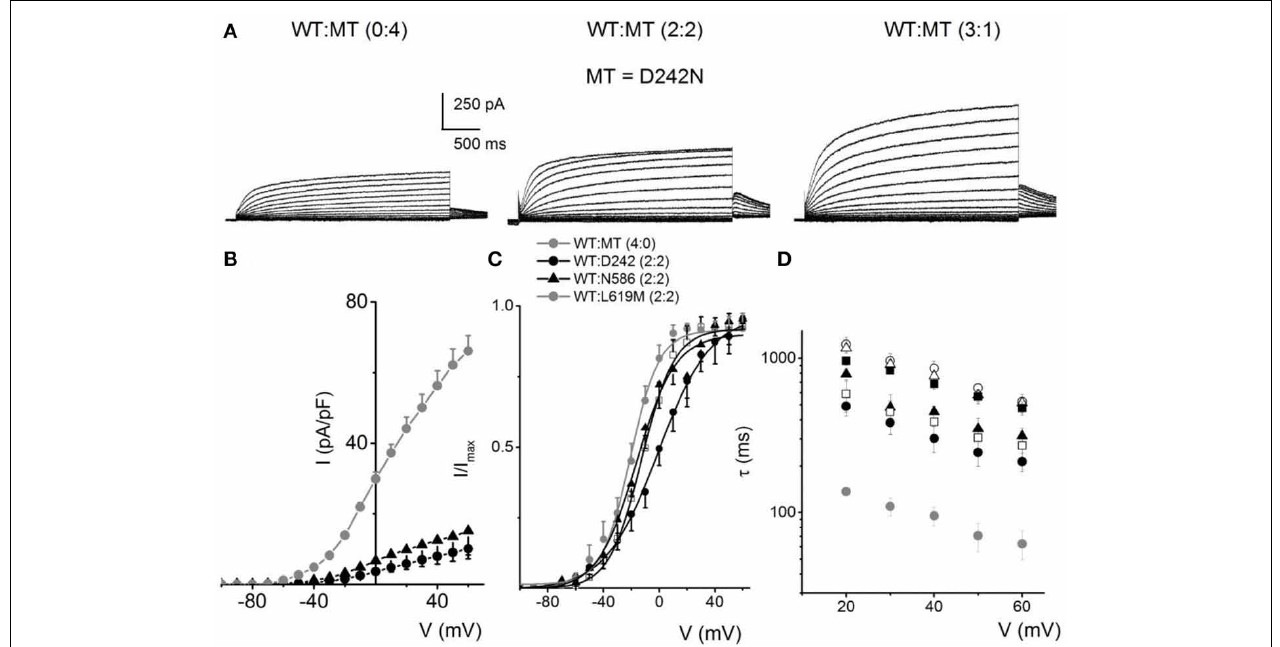
FIGURE 6 | Activation properties of homomeric and heteromeric hKv7.1 channel and RWS mutants, D242N, N586D and L619M currents. (A) Whole-cell outward currents were recorded upon expressing hKv7.1 RWS mutant (MT-D242N) channel singly (left panel). Current traces recorded after co-expressing WT hKv7.1 and MT D242N at a ratio of 1:1 (middle panel). Representative current traces for a family of K + currents obtained from a holding potential of − 80mV and stepped from − 100 to 60mV using (cid:3) V = 10mV are shown. The tail currents were elicited at − 40mV. Current traces recorded from CHO cells transfected with WT:MT-D242N ratio of 3:1 (right panel). (B) Plots of current density-voltage relation of currents derived from WT hKv7.1 alone ( ) and a combination (ratio 2:2) of WT Kv7.1 and mutants (MT-D242N, , MT-N586D, (cid:4) , and MT-L619M, (cid:7) ). (C) Heteromeric association between the WT hKv7.1 and MT-D242N, N586D and L619M at a ratio (2:2) altered the voltage-dependent activation